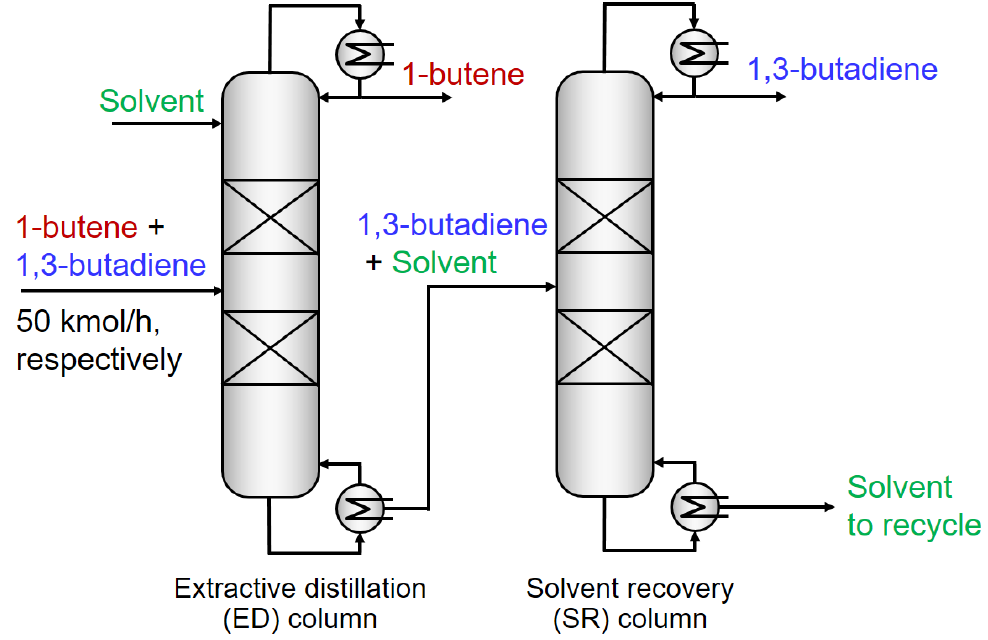
Figure 4. Flowsheet of the ED process for 1,3-C 4 H 6 and n-C 4 H 8 separation.